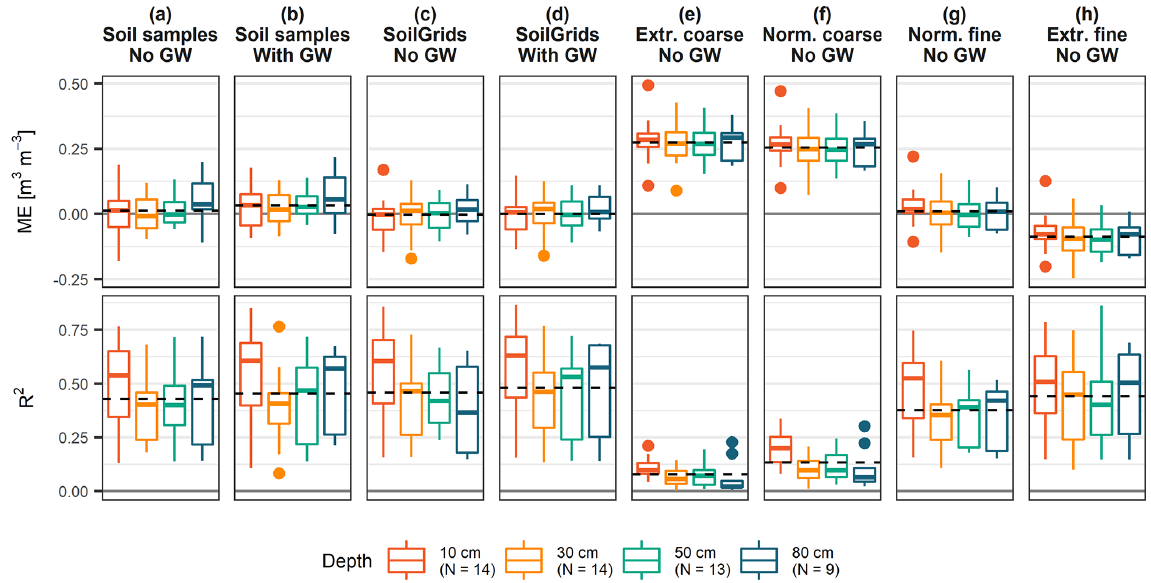
Figure 4. Goodness of fit of simulated versus measured soil moisture variation at the 14 reference sites, with the mean error (ME; top panels) and coefficient of determination ( R 2 ; bottom panels) indicated by sensor depths (different colours) for various CoupModel parameterizations (a–h) . Lower boundary conditions with and without groundwater (GW) are